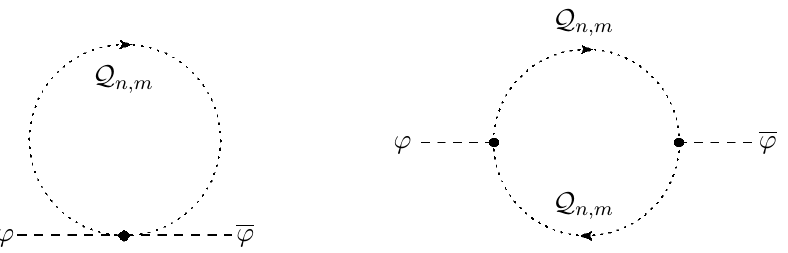
Figure 1. Bosonic contributions to the Wilson line mass without (cid:13)ux.